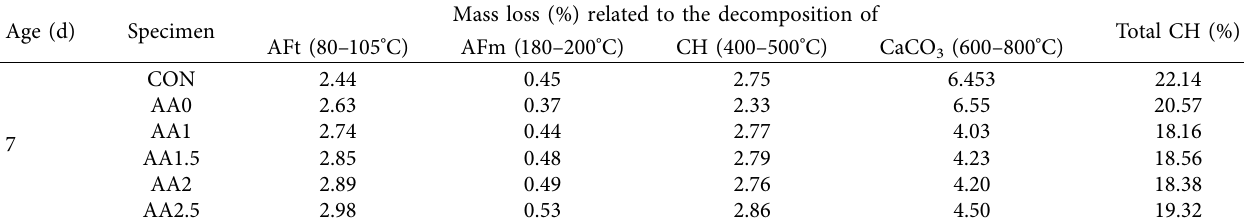
Figure 2. At 7 d, the CH contents of the cement paste with AA were lower than those of the AA0 and CON group, indicating that the mass of CH was consumed due to the reaction with the SiO 32 − of the AA, which was in agreement with the XRD results shown in Figure